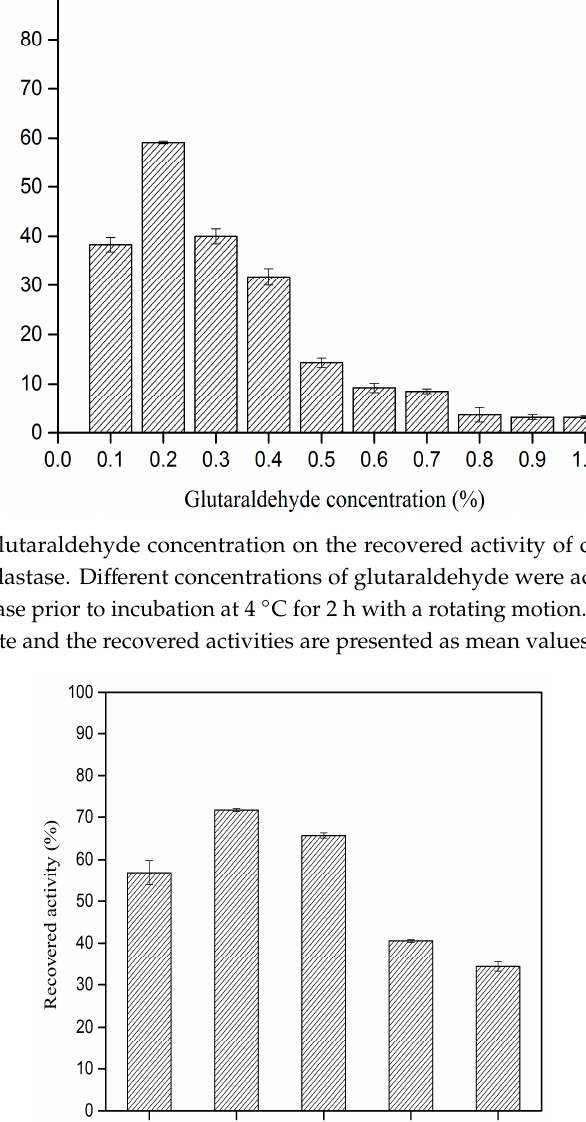
Figure 1. Effect of glutaraldehyde concentration on the recovered activity of cross–linked enzyme aggregate (CLEA)–elastase. Different concentrations of glutaraldehyde were added into aliquots of aggregated free elastase prior to incubation at 4 °C for 2 h with a rotating motion. The experiment was conducted in triplicate and the recovered activities are presented as mean values ± standard error.